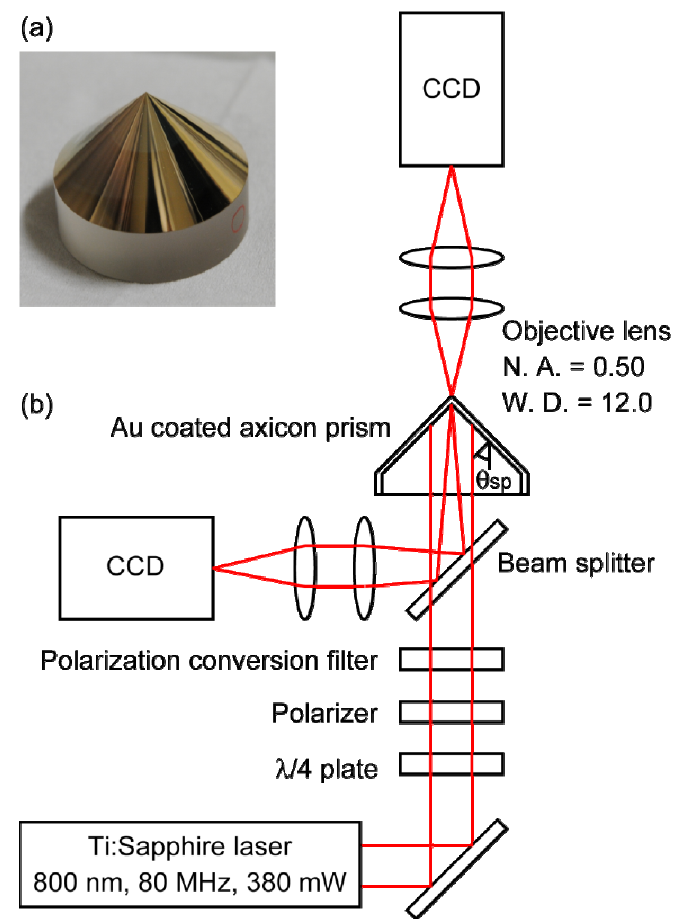
Figure 1. ( a ) Photograph of a gold-coated axicon prism. The gold thickness and the half-cone angle of the prism are optimized for the Kretschmann configuration (excitation wavelength = 800 nm); ( b ) Optical setup for the demonstration of plasmonic nanofocusing. Incident light of collimated Gaussian beam of pulsed laser excites the surface plasmons at the side of the prism. Scattered and reflected images can be